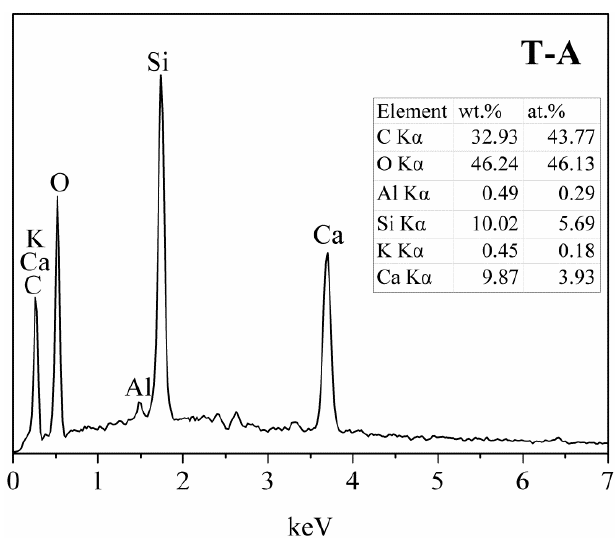
Figure 6. EDX spectra of the T-A sample in Figure 5d.